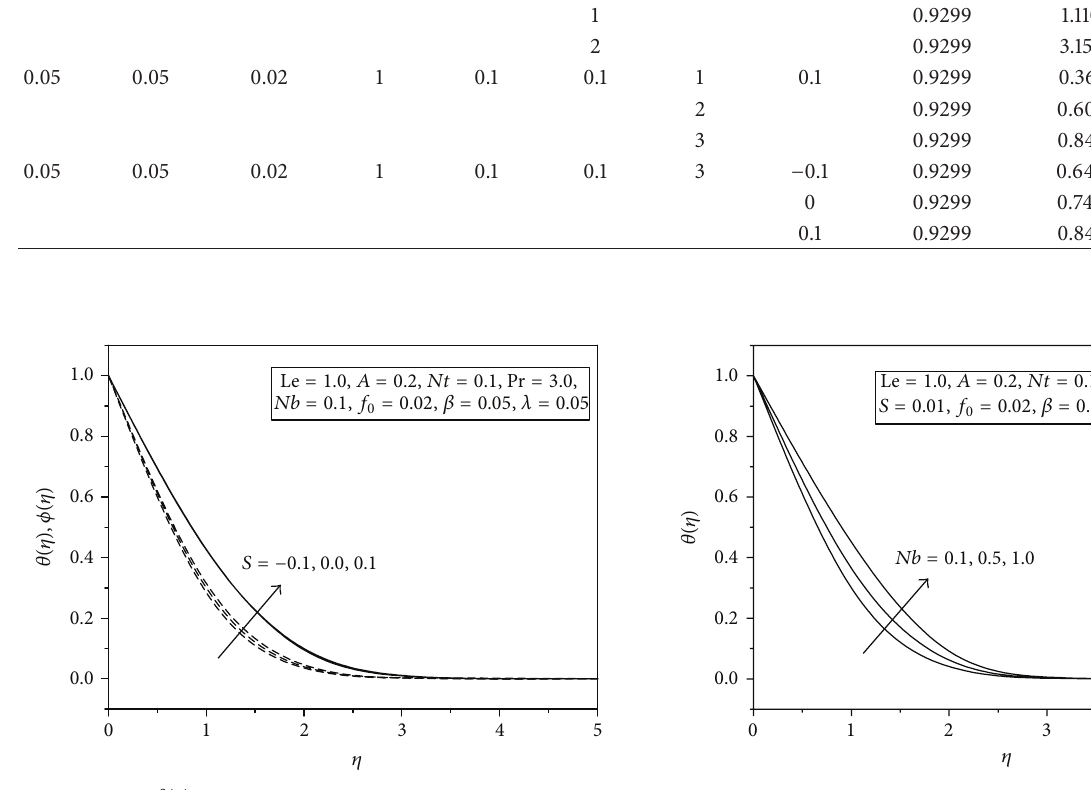
Figure 9: Temperature profile for different values of 𝑁𝑏